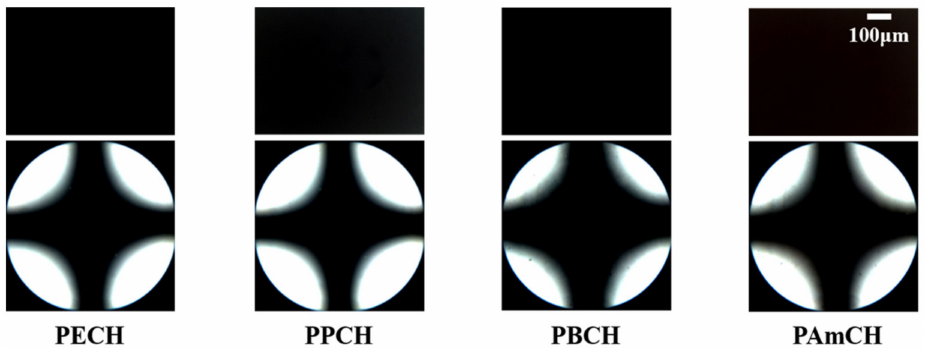
Figure 4. Orthoscopic (top) and conoscopic (bottom) polarized optical microscopy (POM) images of the LC cells fabricated with PECH, PPCH, PBCH, and PAmCH